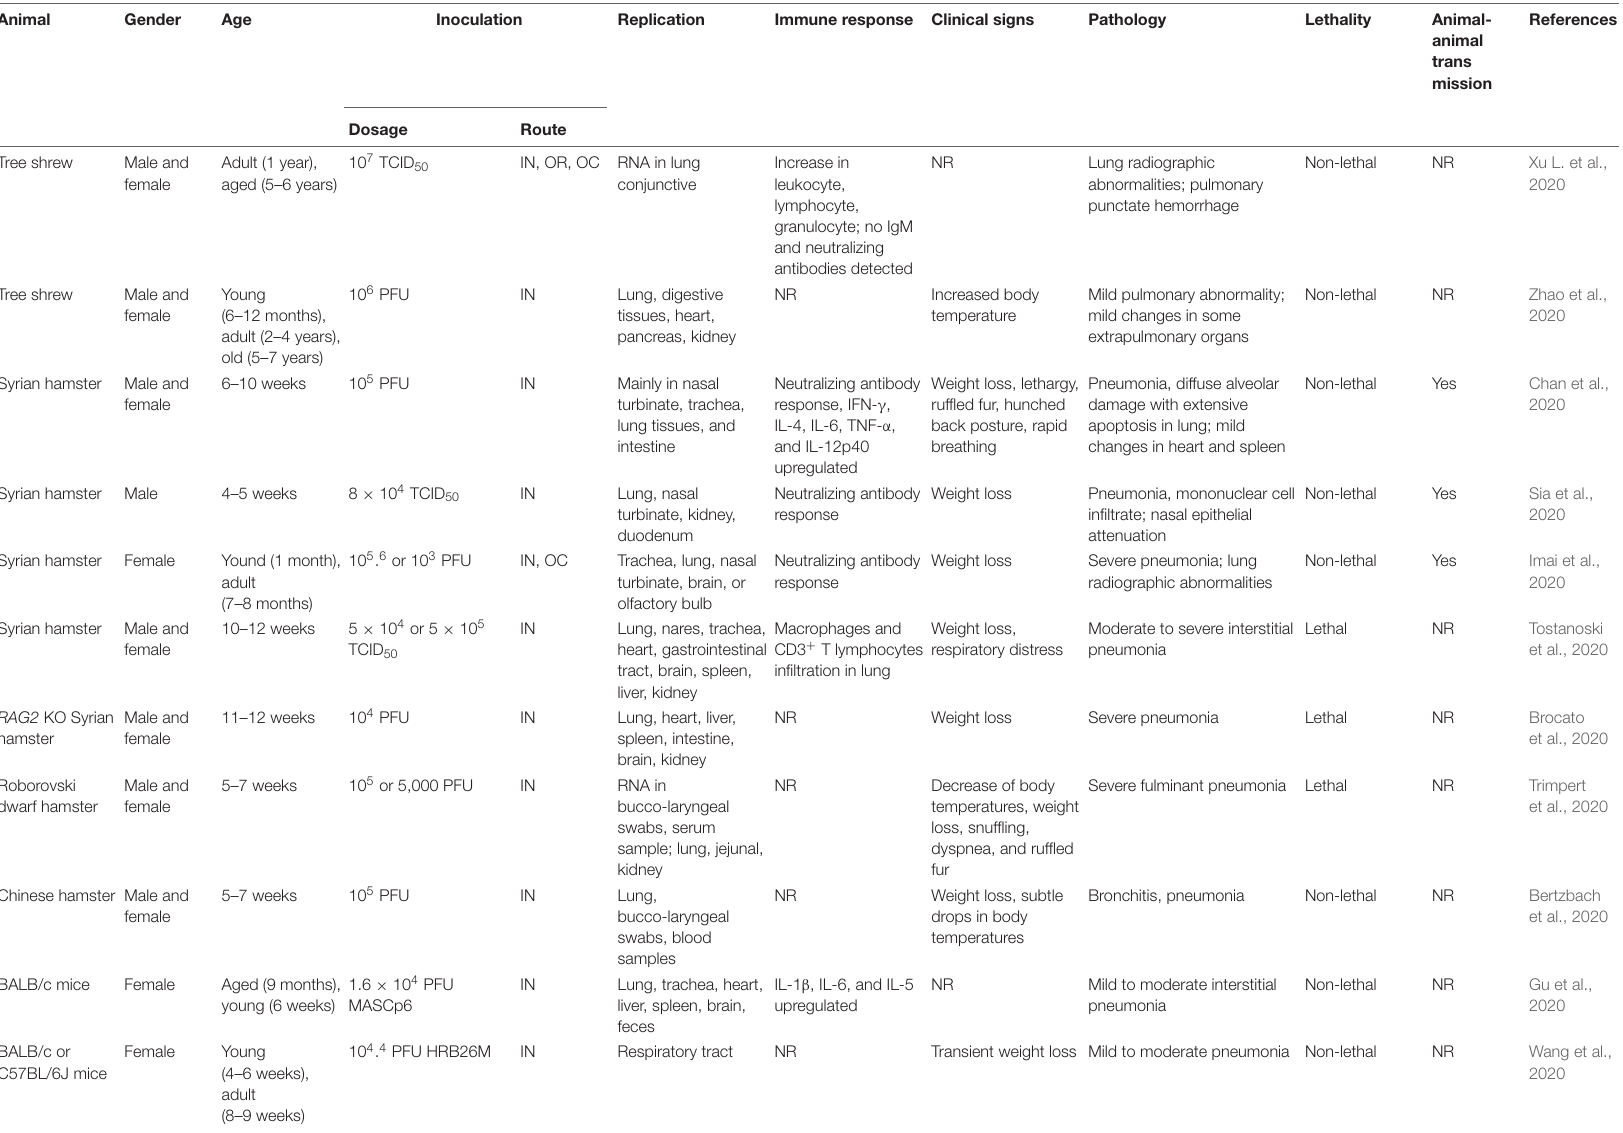
TABLE 1 | Experimental animal models for SARS-CoV-2. Animal Gender